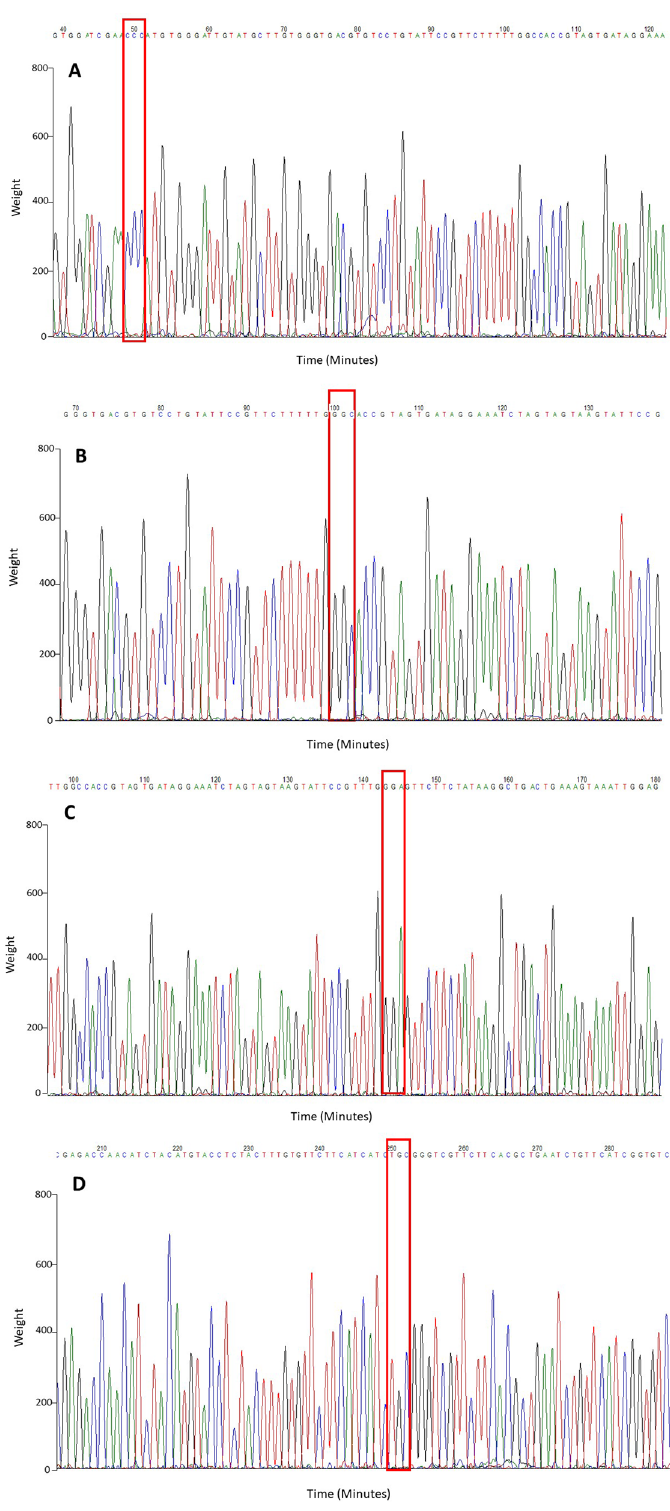
Figure 1. Chromatograph of sequences at a position of homozygous kdr resistance in VGSC domain II regions of ( A ) S989P, ( B ) A1007G (a new novel mutation), ( C ) V1016G, and domain III region of ( D ) F1534C which related to pyrethroid-resistance. A red box indicated the position of the amino